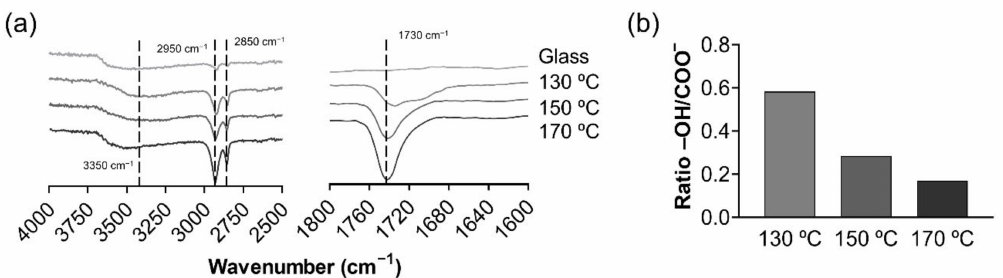
Figure 1. Chemical properties of poly(glycerol sebacate) (PGS) substrates. Fourier transform infrared spectroscopy (FTIR) spectra (transmittance) of PGS substrates obtained at different cured temperatures (130 ◦ C, 150 ◦ C and 170 ◦ C) and glass cover slides. ( a ) Detailed FTIR spectra at the PGS characteristic chemical peak wavelengths: 1600–1800 cm -1 for COO − peak on the right and 4000–2500 cm − 1 for free –OH groups and -CH 2 bonding on the left. ( b ) –OH/COO − ratio obtained from transmittances at 3350 cm − 1 and 2927 cm − 1 .